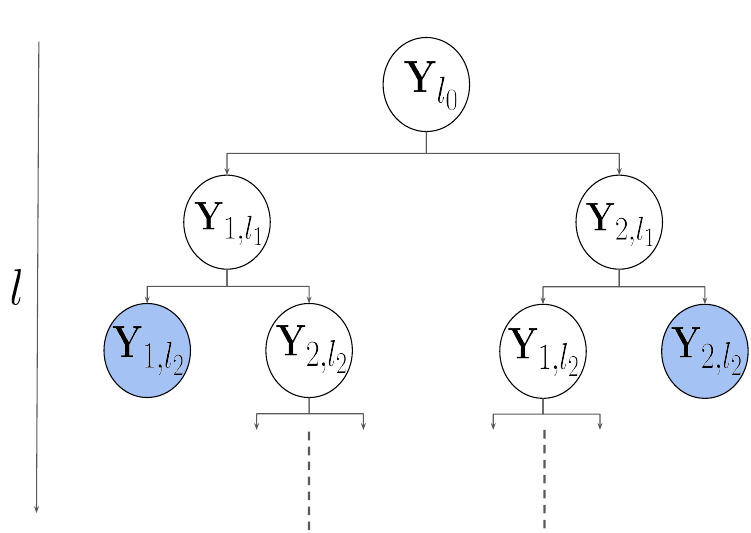
Figure 2. The employed hierarchical structure is presented at different levels ( l b ). The parental nodes are divided into child nodes based on the defined criterion, which uses the reconstruction error values of parental and child nodes (see Section 2.2.3). At l 2 , white nodes present the nodes that will be split further, while the blue nodes present the end-nodes of the hierarchical structure, which will not be split further. Additionally, in each node of the tree, the binary clustering procedure is applied on the data points (see Figure 3).